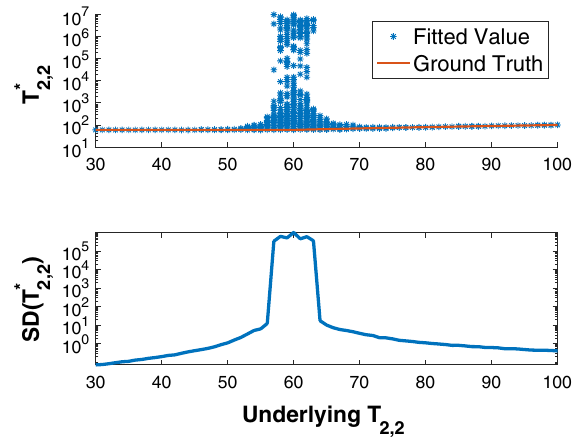
Figure 4. The upper panel shows a scatterplot of the recovered values, T ∗ 2,2 , of T 2,2 over 1000 noise realizations for each value of underlying T 2,2 , with the remaining parameters fixed at The smaller value of the derived time constants is assigned to T 2,1 , and the larger to T 2,2 . SNR = 10000. In the upper panel, correct underlying values of T 2,2 are indicated with the red line, with corresponding values of the recovered T 2,2 shown as asterisks. As T 2,2 increasingly differs from T 2,1 , accuracy and precision both improve greatly. The SD’s for the recovered values of T 2,2 are shown in the lower panel and are seen to be largest in the T regime T 2,2 2,1 , and to decrease as these values progressively differ. ≈